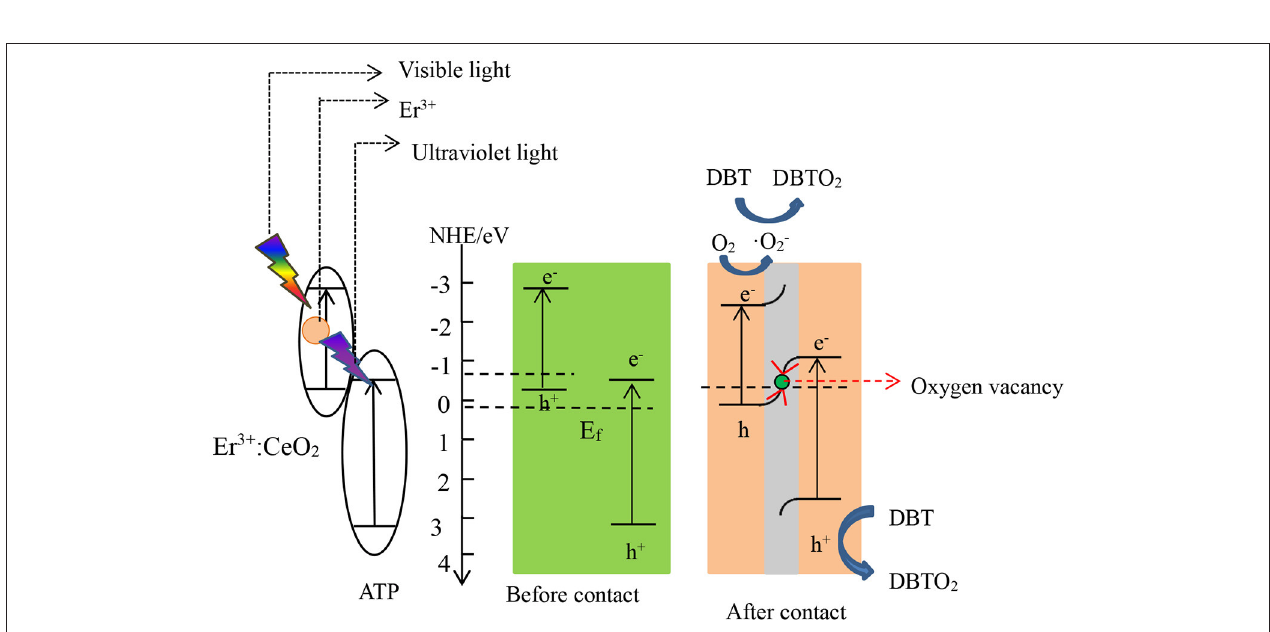
FIGURE 11 | Photocatalytic desulfurization mechanism of Er 3 + :CeO 2 /ATP.